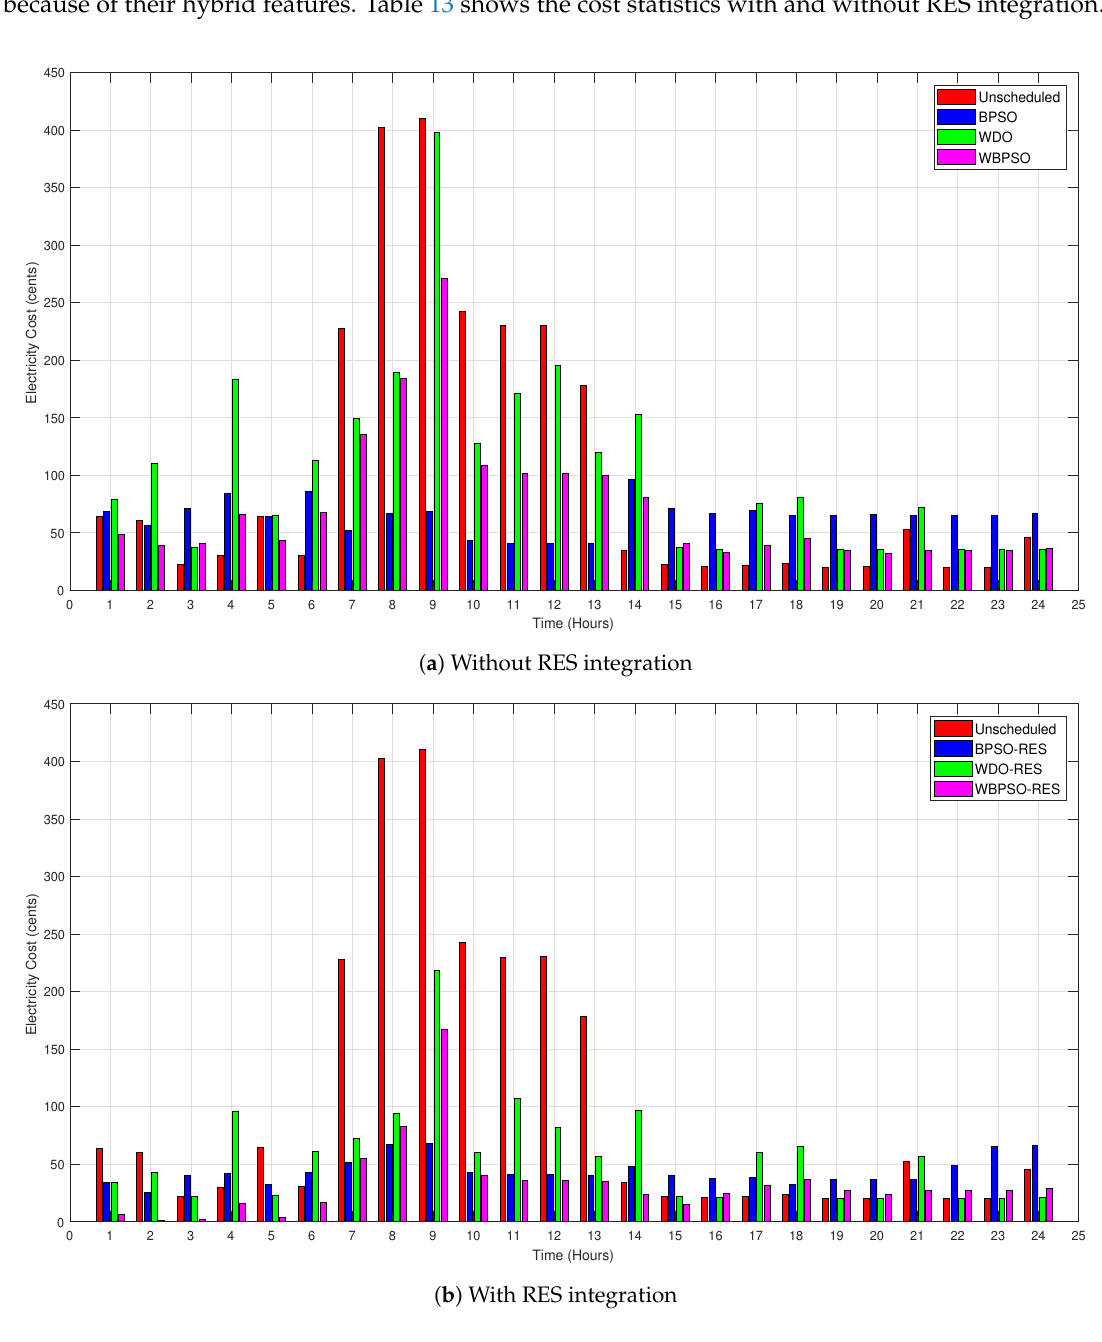
Figure 9. Electricity cost of